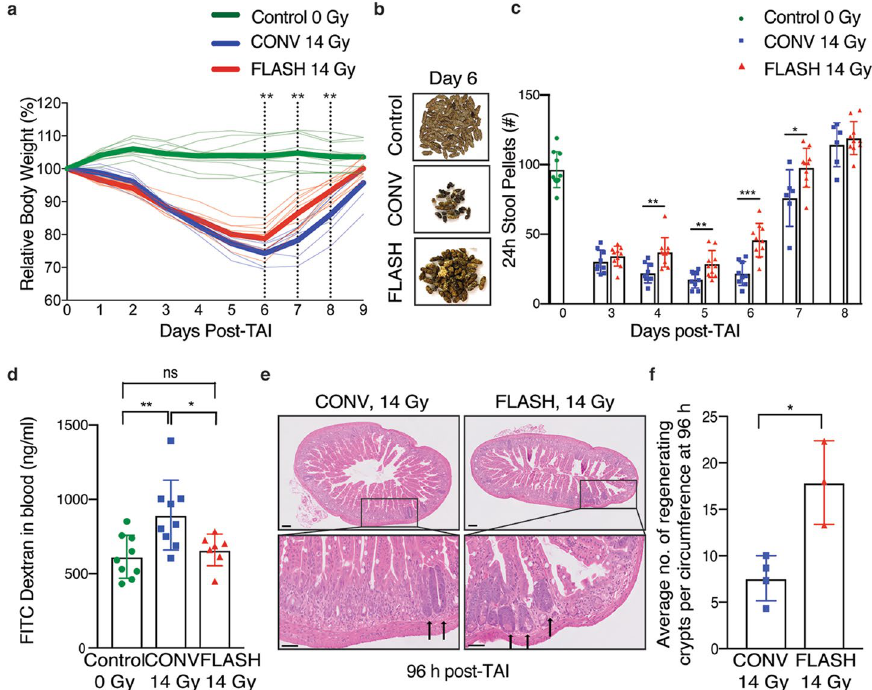
Figure 3. Abdominal FLASH irradiation spares intestinal function and epithelial integrity compared to CONV irradiation at a sub-lethal dose in non-tumor bearing mice. ( a ) Relative body weight (%) of mice over time after 14 Gy CONV or FLASH TAI. Bold lines show the averages for the cohorts. The dotted lines indicate days at which the difference between CONV and FLASH is significant. (n = 10 mice in unirradiated control and FLASH; n = 9 in CONV; n = 6 in CONV on days 7, 8 and 9). ( b ) Representative images of formed stool pellets from singly housed unirradiated control mice and mice six days after sub-lethal 14 Gy TAI, showing an increase in stools after FLASH vs. CONV. ( c ) Quantification of the number of formed stool pellets excreted over 24 h at the indicated time points from unirradiated control mice and mice after 14 Gy TAI, demonstrating less severe decrement and faster recovery after FLASH vs. CONV irradiation (n = 10 mice in unirradiated control & FLASH; n = 9 in CONV; n = 6 in CONV on days 7 and 8). ( d ) Quantification of FITC-dextran in serum at 96 h after 14 Gy TAI, demonstrating loss of intestinal barrier function after CONV but not FLASH irradiation (n = 9 mice in unirradiated control and CONV; n = 7 in FLASH). ( e ) Histological images of H&E stained jejunal sections from animals 96 h after 14 Gy TAI. Arrows point to regenerating crypts. ( f ) Quantification of the average number of regenerating crypts per jejunal circumference 96 h after 14 Gy TAI, demonstrating over double the number of regenerating crypts after FLASH vs. CONV irradiation (n = 4 mice in CONV; n = 3 in FLASH; 3 circumferences per mouse were analyzed). *p < 0.05, **p < 0.01, ***p < 0.001. CONV vs. FLASH compared by unpaired 2-tailed Student’s t-test. Unirradiated control vs. CONV or FLASH compared by one-way ANOVA followed by Tukey’s multiple comparisons post-hoc test. Scale bar shows 100 μm. Error bars represent standard deviation of the